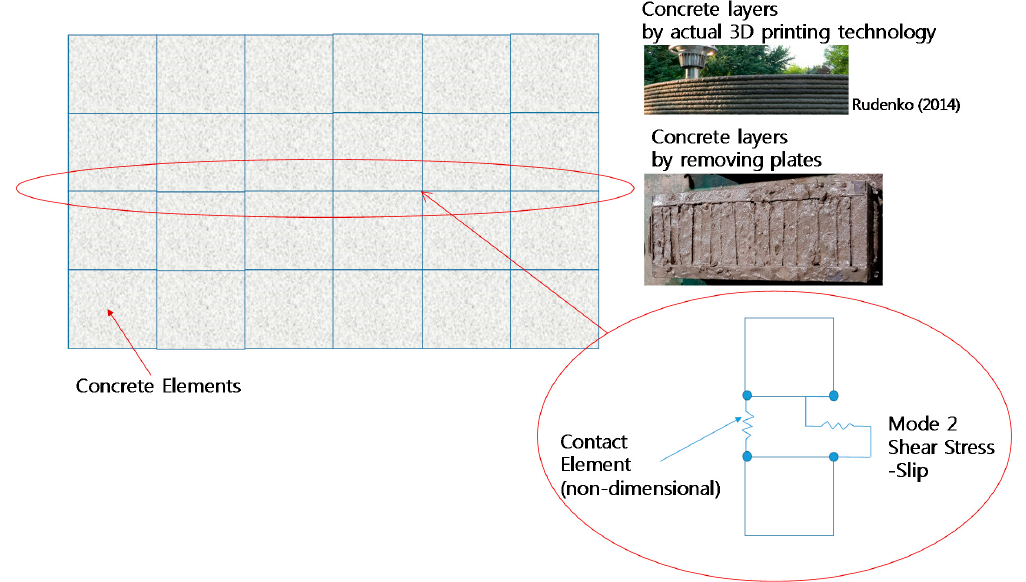
Figure 16. Modeling of interface between two concrete layers.